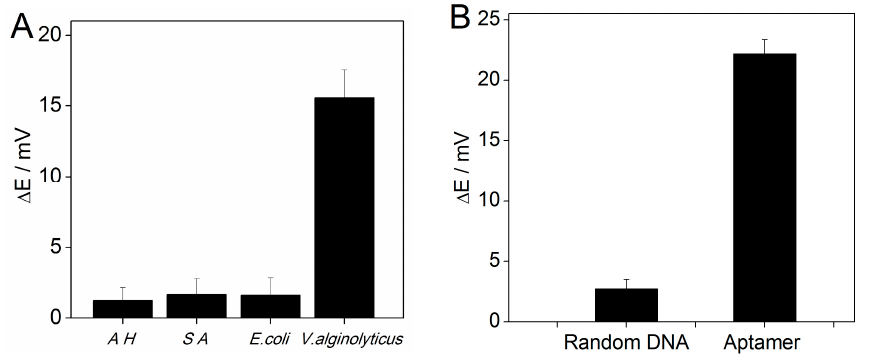
Figure 6. ( A ) Potential changes in the presence of 500 CFU mL − 1 Aeromonas hydrophila (AH), Staphylococcus aureus (SA), E. coli , and 50 CFU mL − 1 V. alginolyticus . ( B ) Potential responses to 100 CFU mL − 1 V. alginolyticus using the aptamer and random DNA-based DNA nanostructures. Error bars represent one standard deviation for three measurements.